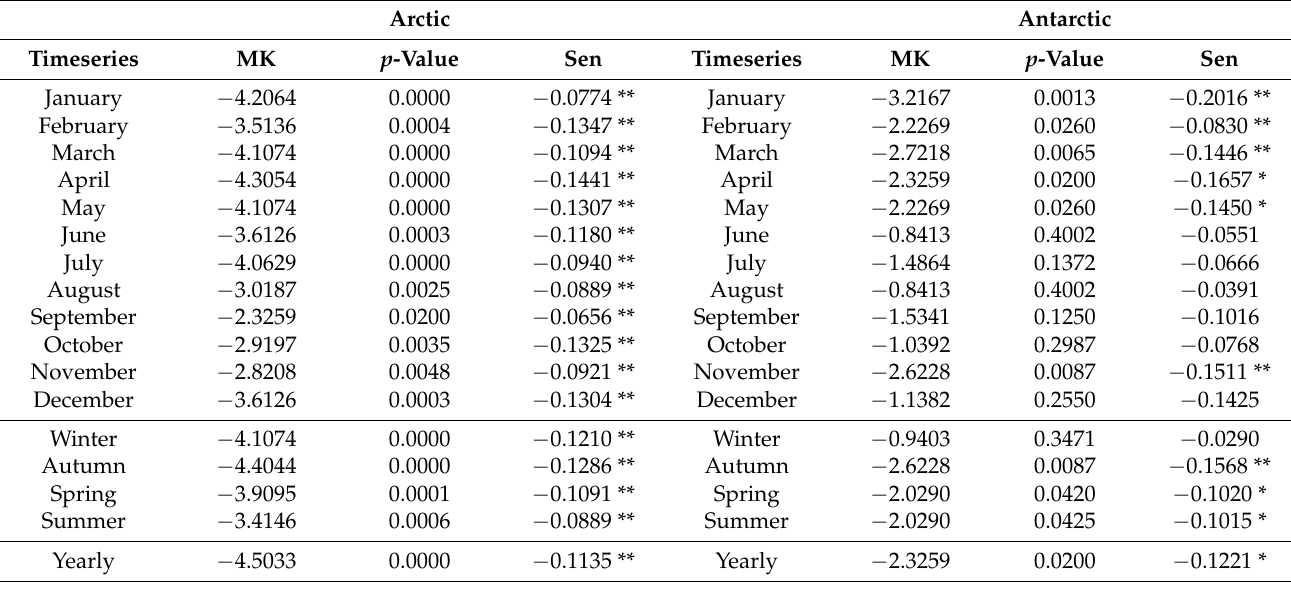
Table 3. Mann–Kendall (SK) test and Sen’s slope estimator (Sen) results for the significance of trends in monthly and seasonal ice sheet area in the Arctic and Antarctic from 2005–2019.